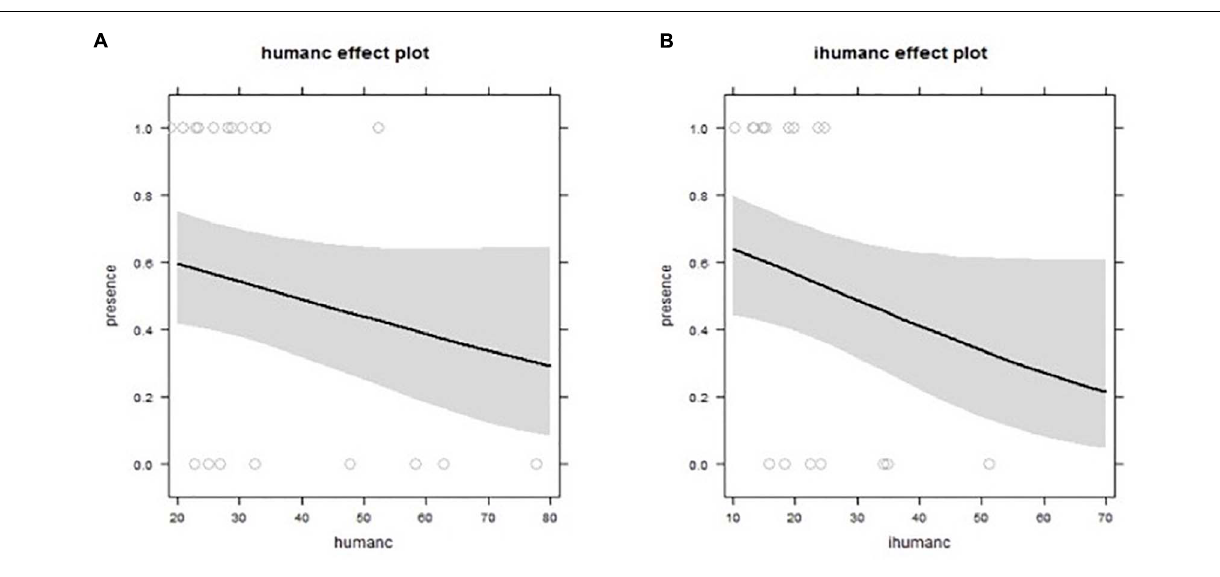
FIGURE 7 | Relationship between territorial abandonment in relation to (A) current human development (humanc), from best fitting model (1 km radii); and in relation to (B) longer term percentage change in human development (ihumanc), from the best fitting model (0.1 km